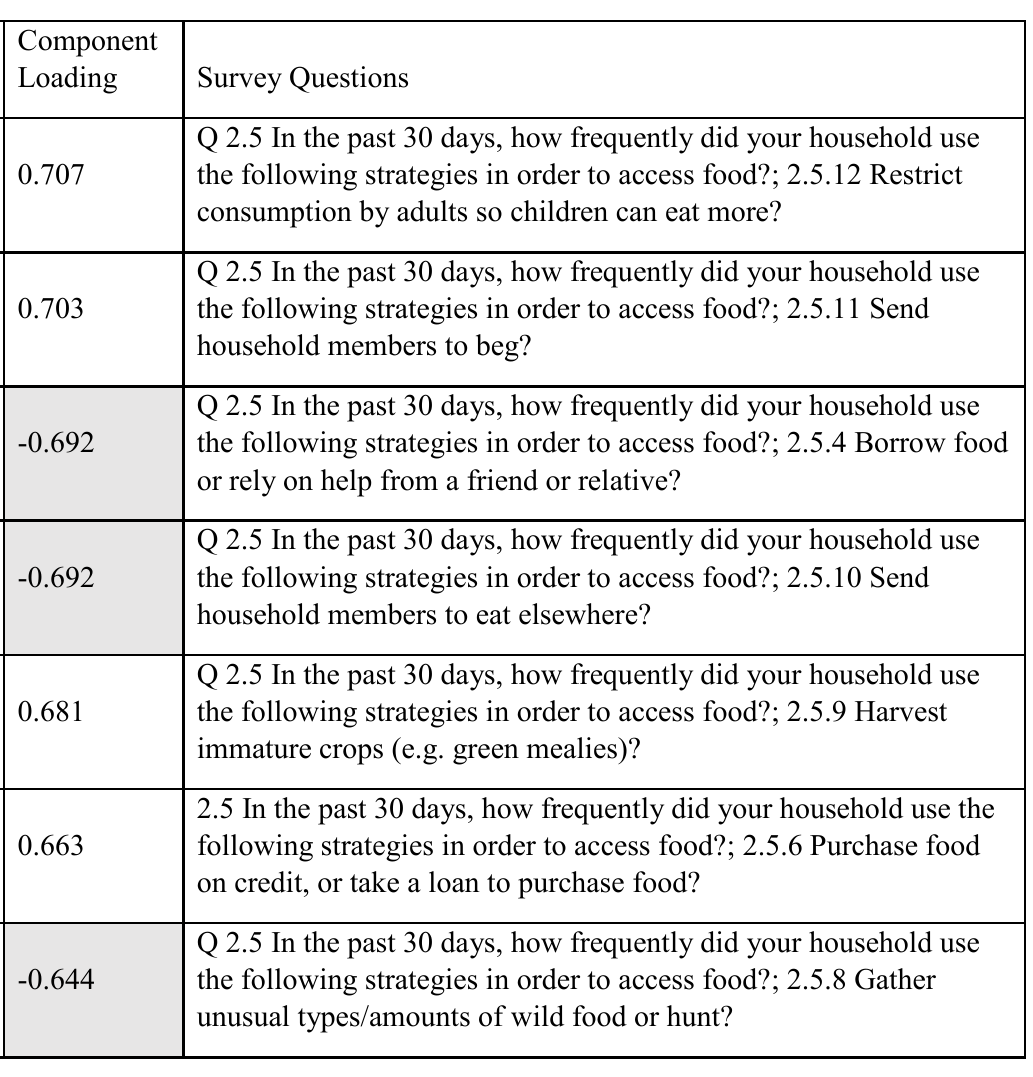
Table 1.2: Variables defining Absorptive Resilience PC1